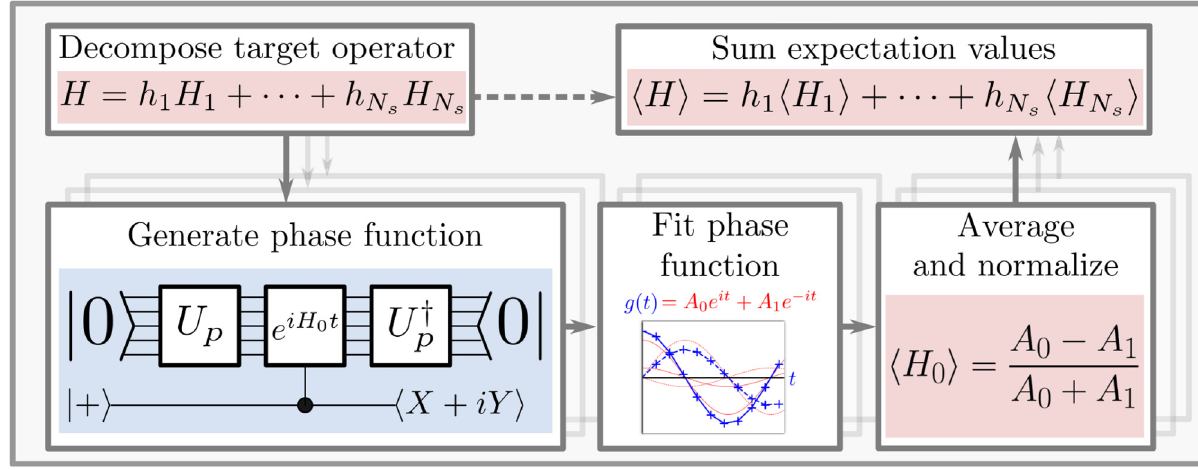
|(cid:6) FIG. 1. Process diagram of the protocol for verified estimation of the expectation value of a Hamiltonian on a state | ψ (cid:2) = U p 0 (cid:2) . Blue denotes circuits to be executed or data to be extracted from a quantum computer; red denotes signal details to be estimated via classical postprocessing. The protocol proceeds as follows. Top left: a complex Hamiltonian H is split into a number of fast- forwardable summands H s . The spectral function g ( t ) of | (cid:3) (cid:2) under time evolution of each piece is obtained (bottom left) via verified, fast-forwarded phase estimation. In this example, a control qubit is used to extract the phase function via phase kickback. The resulting of the corresponding factor (bottom middle). data form a weighted sum of oscillations with frequencies equal to the eigenvalues E ( s ) j This may be decomposed in a variety of classical postprocessing techniques to obtain estimations of the expectation values (cid:3) H s (cid:2) depending on the type of H s chosen (bottom right). Regardless of the method used, the expectation values must be normalized to obey Eq. (24), the last step in the verification process. As the expectation value is linear, the verified estimates of (cid:3) H s (cid:2) obtained may be immediately summed together to give a verified estimate for (cid:3) H (cid:2) (top